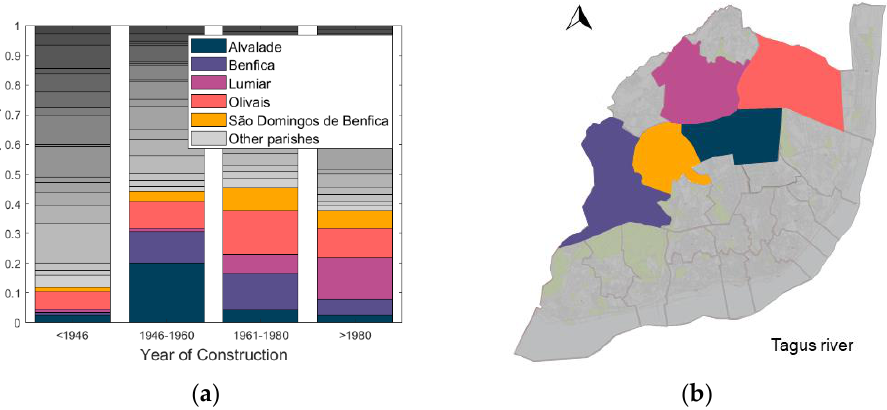
Figure 5. ( a ) Disaggregation of RC building stock across the various parishes of Lisbon and ( b ) spa- tial location of these parishes in Lisbon district. location of these parishes in Lisbon